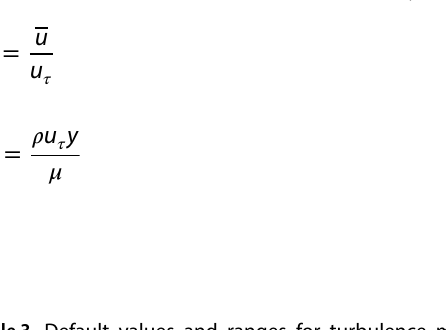
Table 3 Default values and ranges for turbulence model param- eters